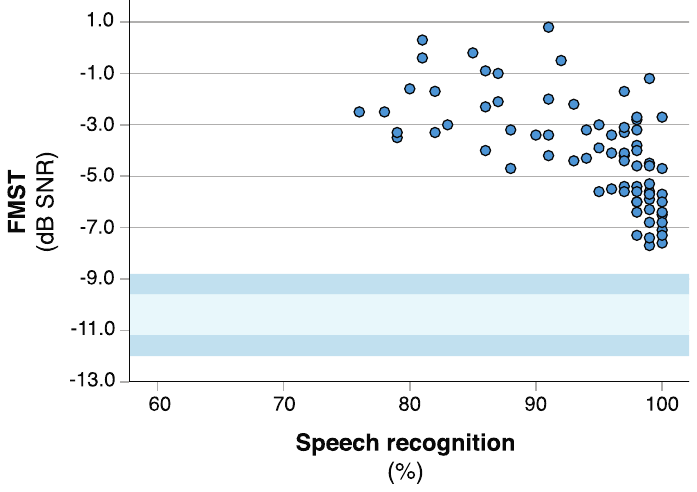
Figure 4. Speech recognition scores at +10 dB plotted against the speech recognition threshold estimates obtained with the adaptive test procedure for the Finnish matrix sentence test (FMST). The light blue represents the normative range ±1 standard deviation (SD) for the FMST, and the dark blue areas denote the ±2 SD range.